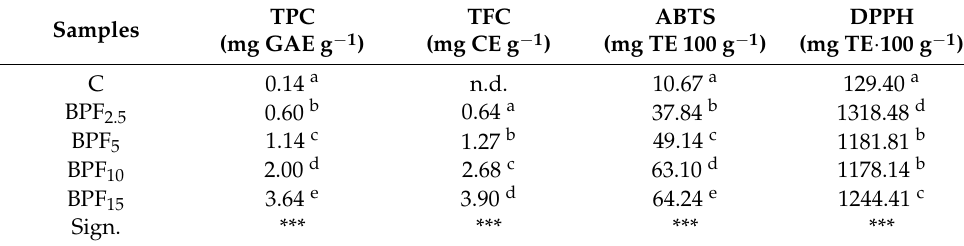
Table 6. Total antioxidant capacity (TPC, TFC, ABTS and DPPH) of the biscuits samples.